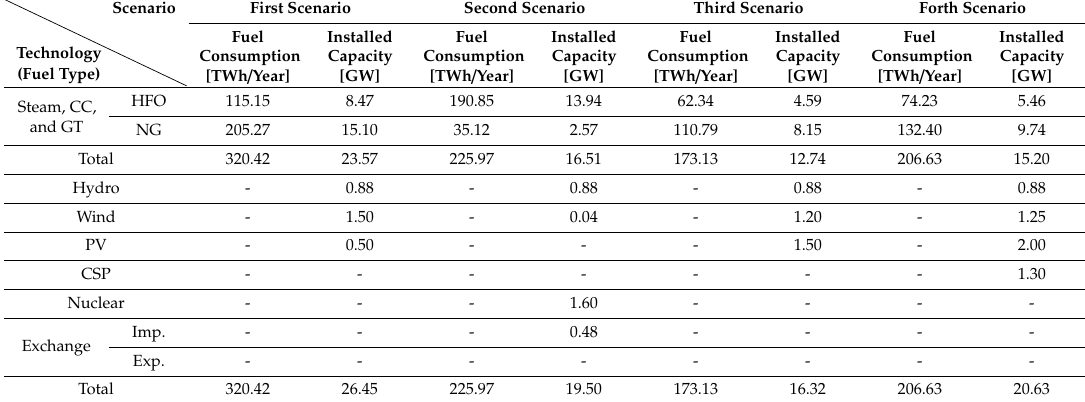
Table 9. Fuel consumption and installed capacity by technology for the studied four